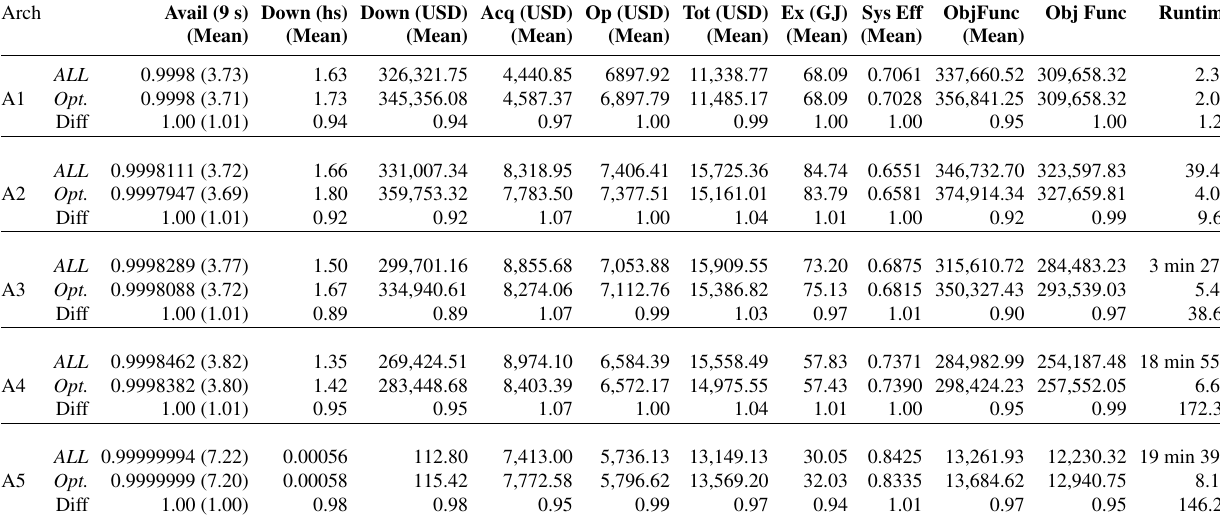
Table 3. Comparing optimal results (ALL, all possible combinations) with optimization algorithm (Opt.) estimates. Avail, availability; 9 s, the availability level ( A ) in the number of nines ( − log[1 − A/100]); Down., downtime; Acq., acquisition cost; Op, operational cost; Tot, total cost; Ex, exergy consumption; Sys Eff, system efficiency; Obj Func, objective function; Diff.,